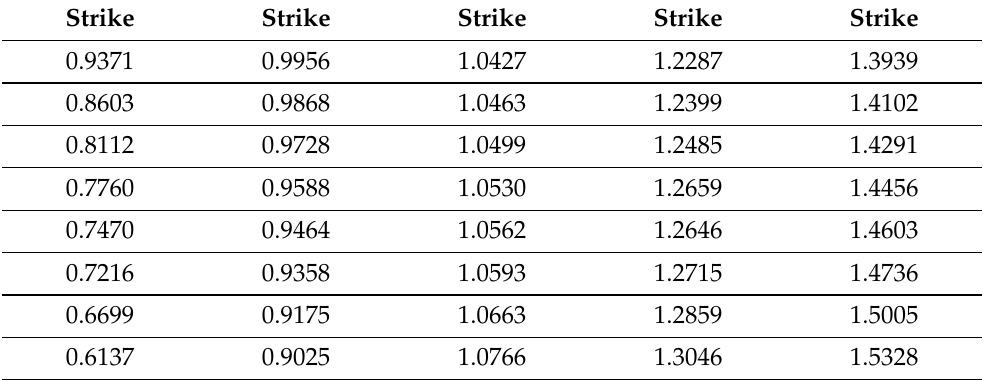
Table A1. Set 1 of strikes and expiries. All the strikes have the same expiry τ = 0.119047619047619.